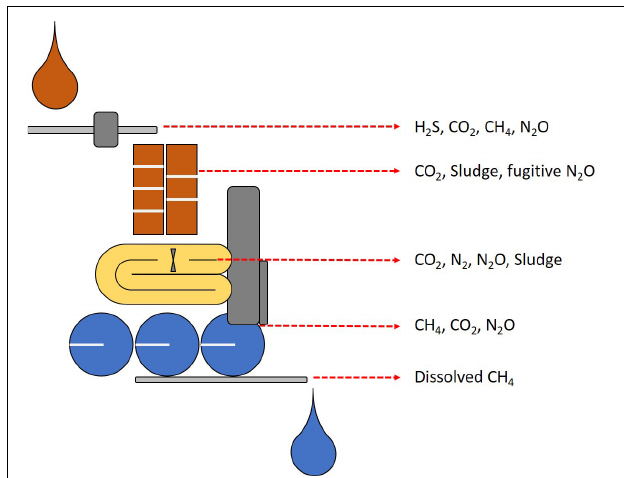
FIGURE 5 | Schematic representation of the detrimental emissions from WWT. In brown, sewage transport and activated sludge systems produce nitrogen, sulfur and carbon gas emissions and large quantities of sludge. In yellow, canonical N/dN nitrogen removal systems can release nitrous oxide as the main concern, PN/A systems representing improvements in nitrogen removal ( Figure 4 ). In grey, anaerobic digestion systems where primarily methane emissions take place from dissolved methane in effluents, and in blue, post treatment where dissolved emissions escape to the atmosphere and residual sludge is disposed with additional GHG